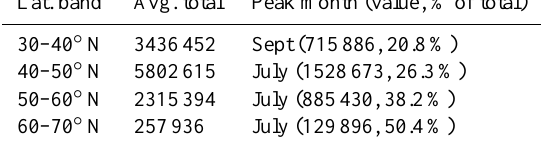
Table 1. Statistics of flashes detected in four latitude bands across